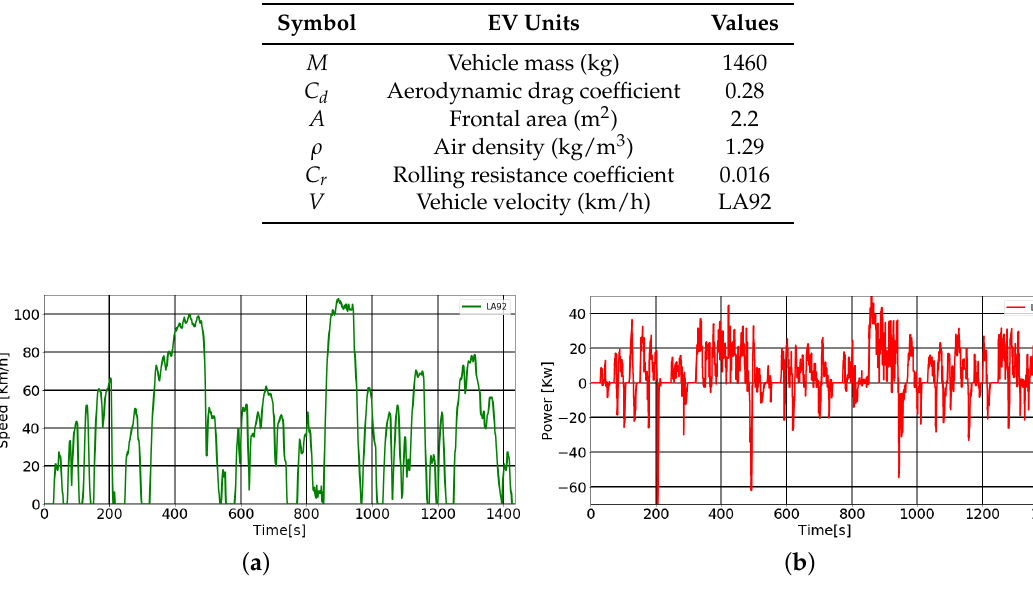
Figure 2. LA92 dynamometer driving schedule (LA92) used to estimate the load. ( a ) The speed of LA92; ( b ) The power of